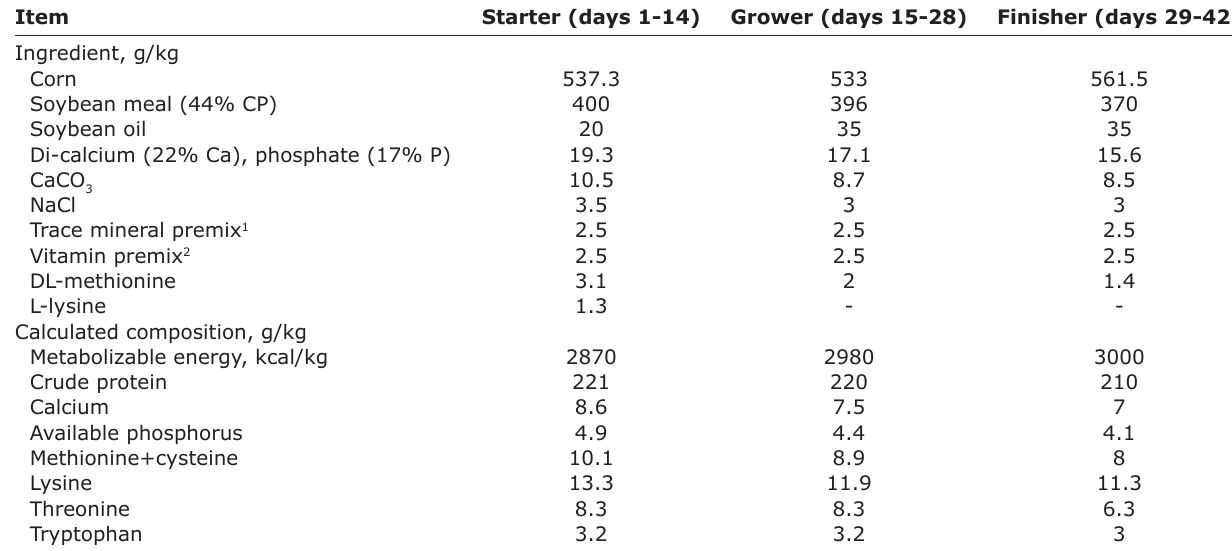
Table-2: The ingredient and calculated composition of basal starter, grower, and finisher diets (as-fed basis).